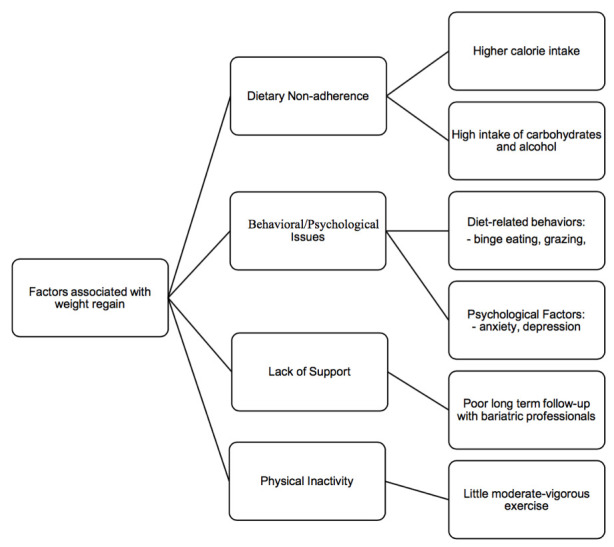
Conceptual framework.This conceptual framework depicts the factors associated with weight regain including dietary non-adherence, behavioral/psychological issues, lack of support, and physical inactivity, as well as the subgroups specific to each factor.